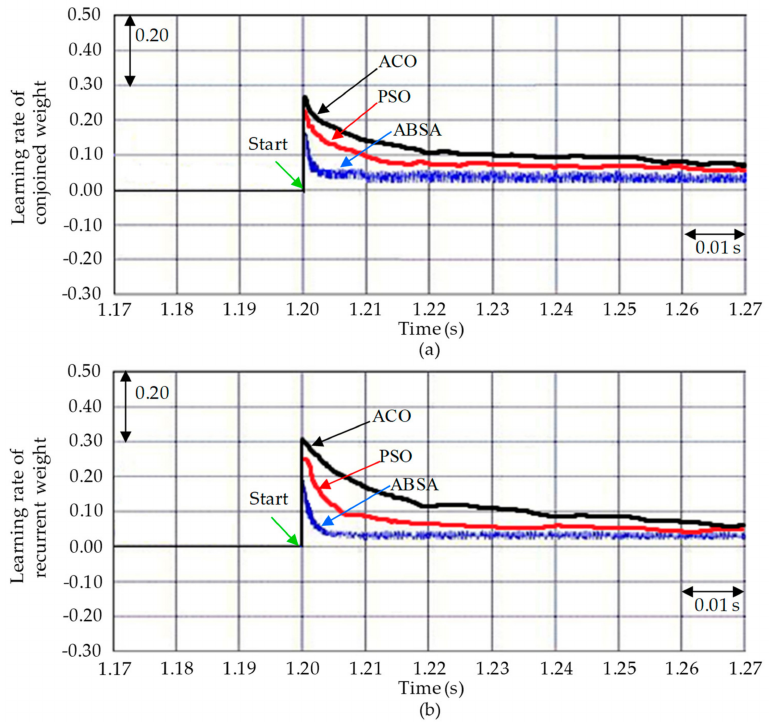
Figure 15. Responses of two learning rates via experimental results of test JB by adopting the ant colony algorithm (ACO), particle swarm optimization (PSO) and altered bat search algorithm (ABSA) methods for: ( a ) learning rate of conjoined weight, ( b ) learning rate of recurrent weight.